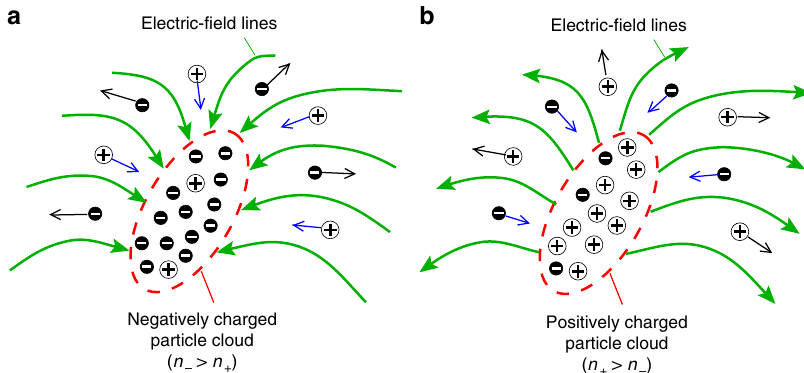
Fig. 3 Mitigation effects of electrostatics on preferential concentration. a A cloud of negatively charged particles generates incoming electric- fi eld lines that steer negative charges away and concentrate positive charges, which tends to electroneutralize the particle charge distribution and overrides the preferential concentration created by the turbulent fl ow fi eld (schematics, not to scale). b A similar but opposite phenomenon is illustrated for a